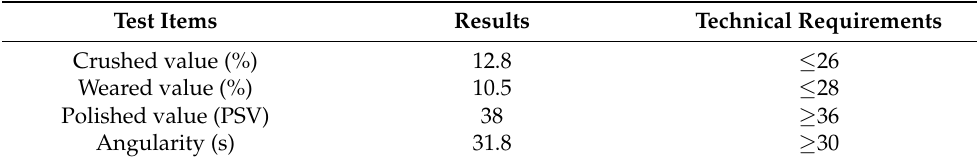
Table 1. Aggregate properties.